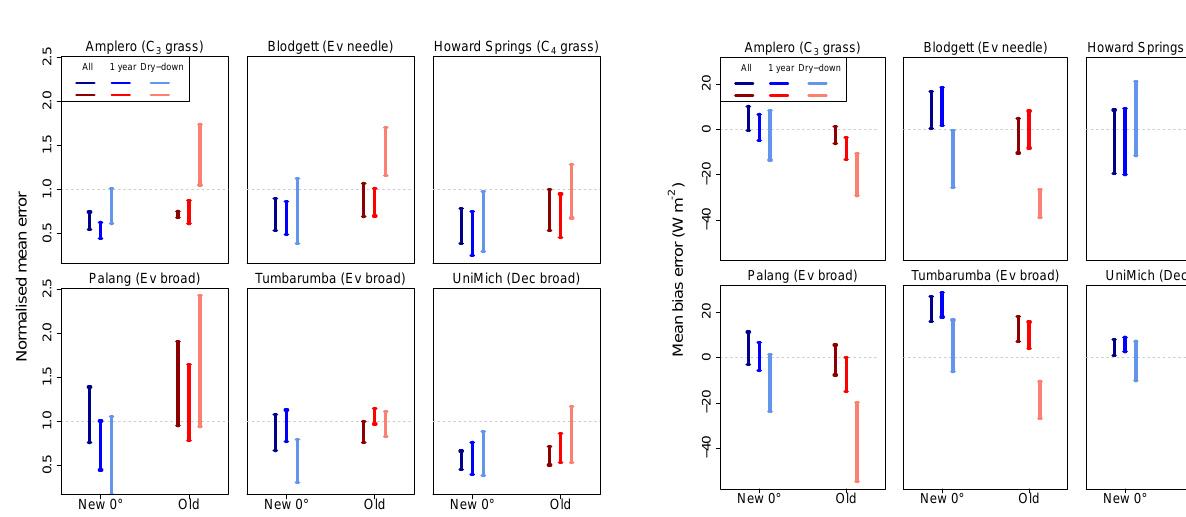
Figure 3. The range in normalised mean error metrics of latent heat simulations using the default (red) and new (blue) hydrological schemes with alternative LAI, g s and soil parameterisations during the whole, annual and dry-down periods. Values closer to 0.0 indi- cate better model performance.